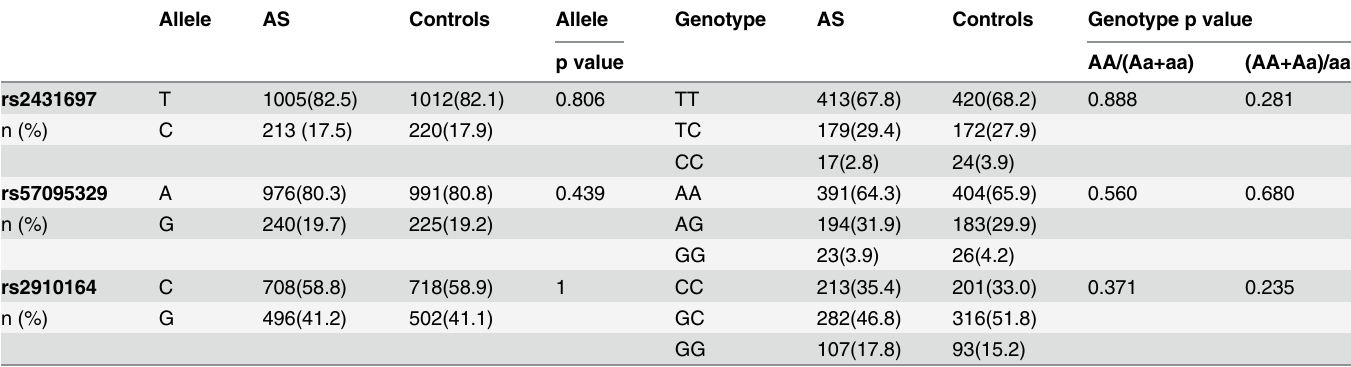
Table 1. MIR146A gene SNPs distribution in AS and control subjects.